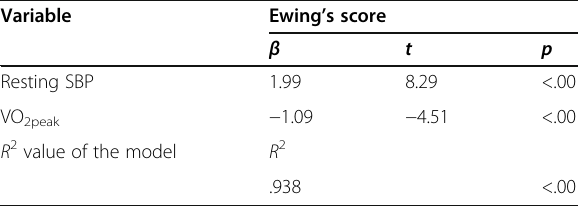
Table 4 Linear regression model for factors associated with Ewing ’ s